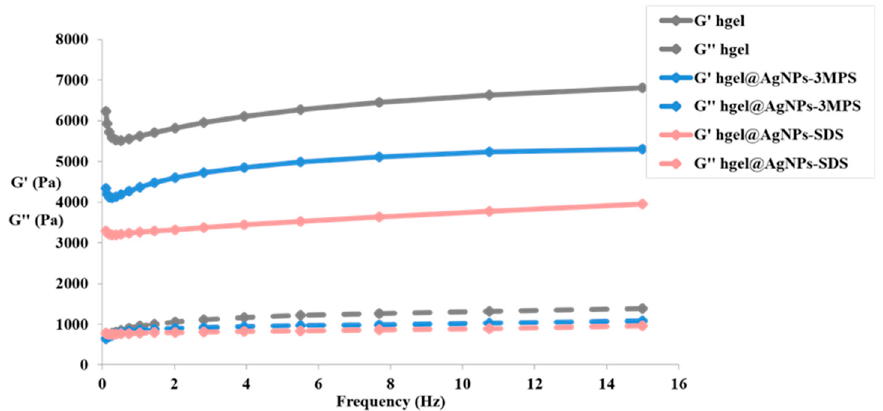
Figure 5. Frequency sweep of the hydrogel; hgel@AgNPs-3MPS; and hgel@AgNPs-SDS.